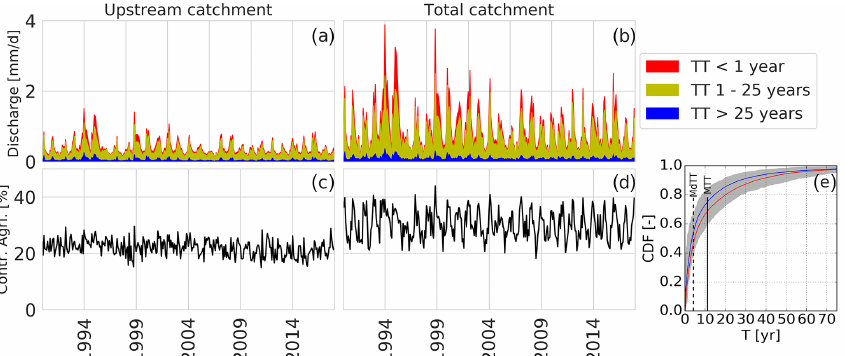
Figure 2. The three age classes of the travel time distributions of the discharge in the Springendalse Beek for the upstream part of the catchment (a) and the total catchment (b) . The lower panels show the percentage of discharge originating from agricultural fields for the upstream part of the catchment (c) and the total catchment (d) . Panel (e) shows the time-weighted averaged cumulative distribution function (CDF) of the travel time distributions of the total catchment in summer (red) and winter (blue) and the overall median and mean